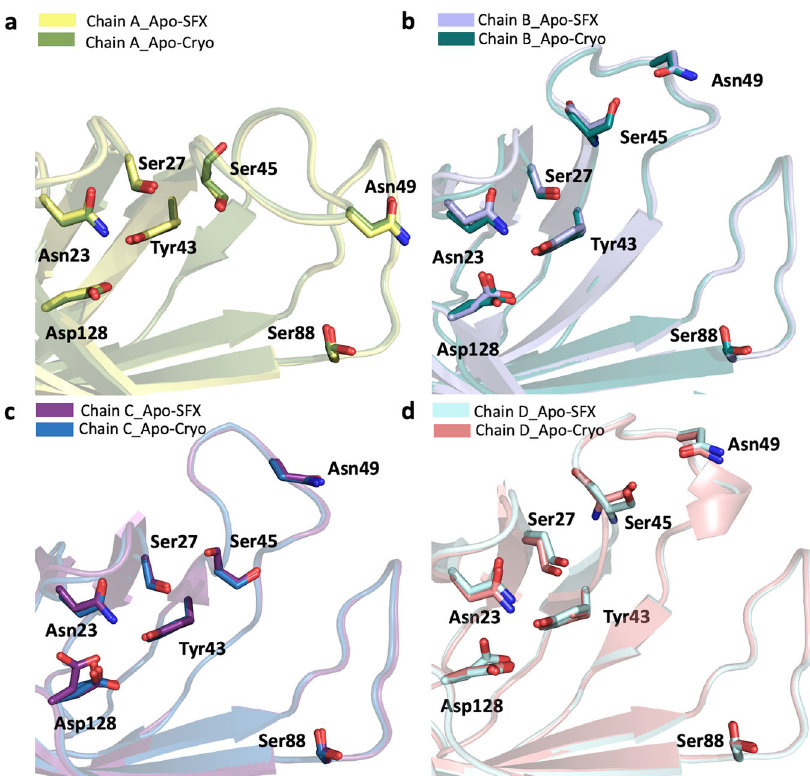
Fig. 2 Biotin-binding site comparison of Apo-SFX and Apo-Cryo structures of streptavidin. Chains A – D of Apo-SFX is superposed with Apo-Cryo structure in a – d , respectively (Supplementary Table 1). There are no signi fi cant conformational differences between the two